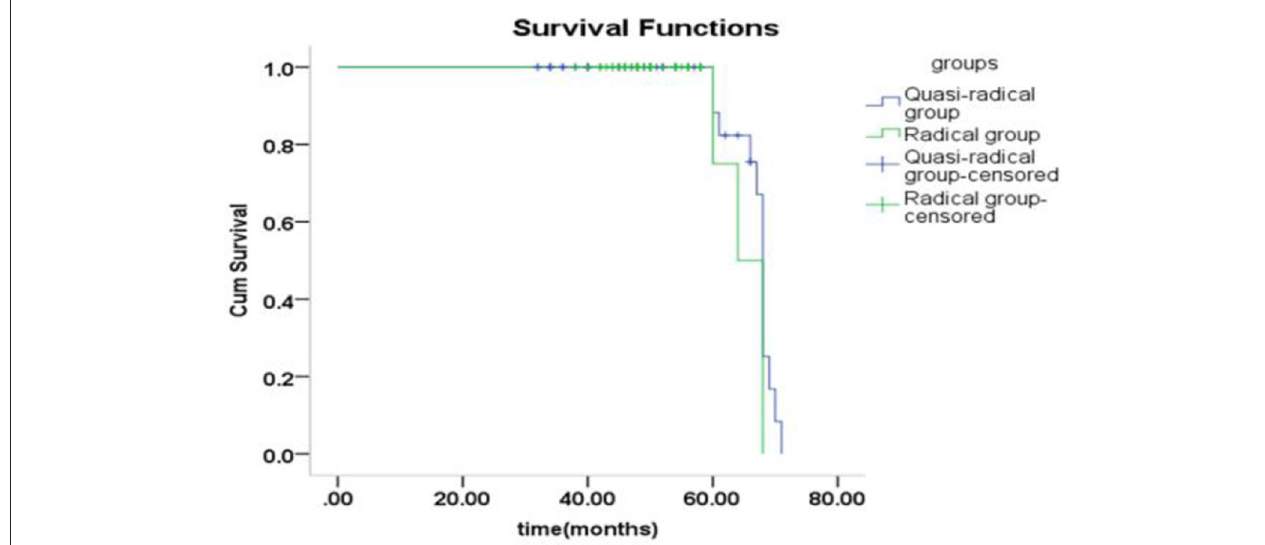
FIGURE 1 | The survival analysis of the two groups of patients with different surgical methods.